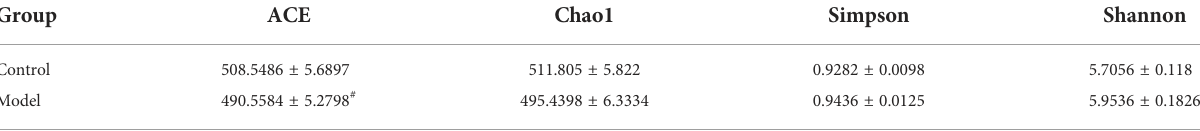
TABLE 4 Alpha diversity index analysis of fecal bacterial microbiota of Cynomolgus macaques ( (cid:1) X ±